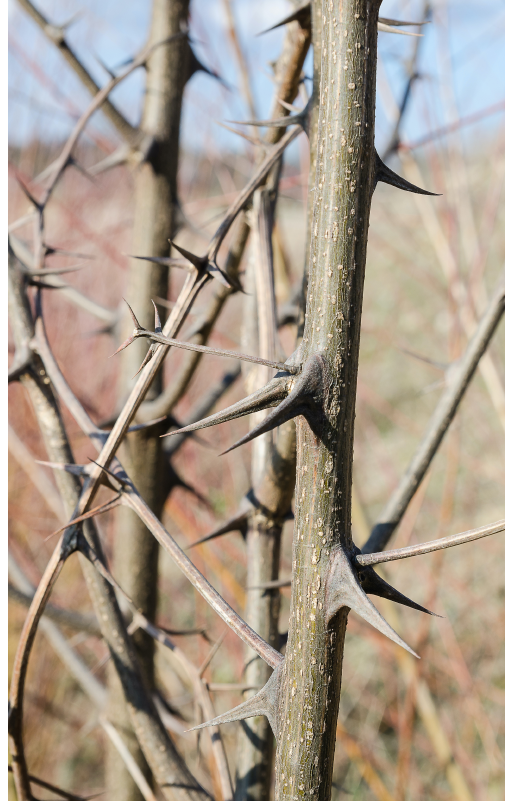
Figure 3. Robinia pseudoacacia , commonly known as black lo- cust, populated with Pantoea agglomerans. Picture from place of accident near Zurich,